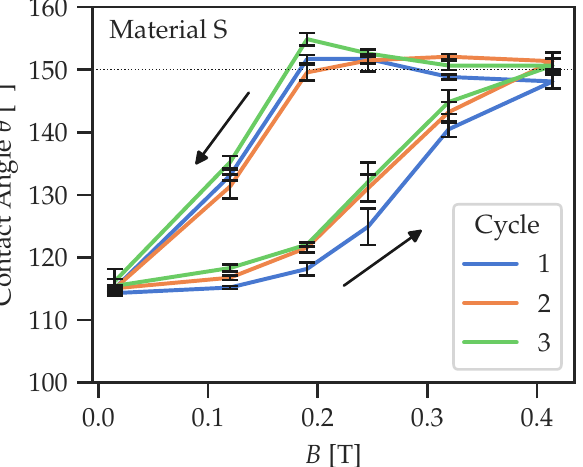
Figure 15. Magnetic-field dependence of the static contact angle for an unstructured MAE sample. Three magnetization cycles are shown. The arrows designate the direction of magnetic-field